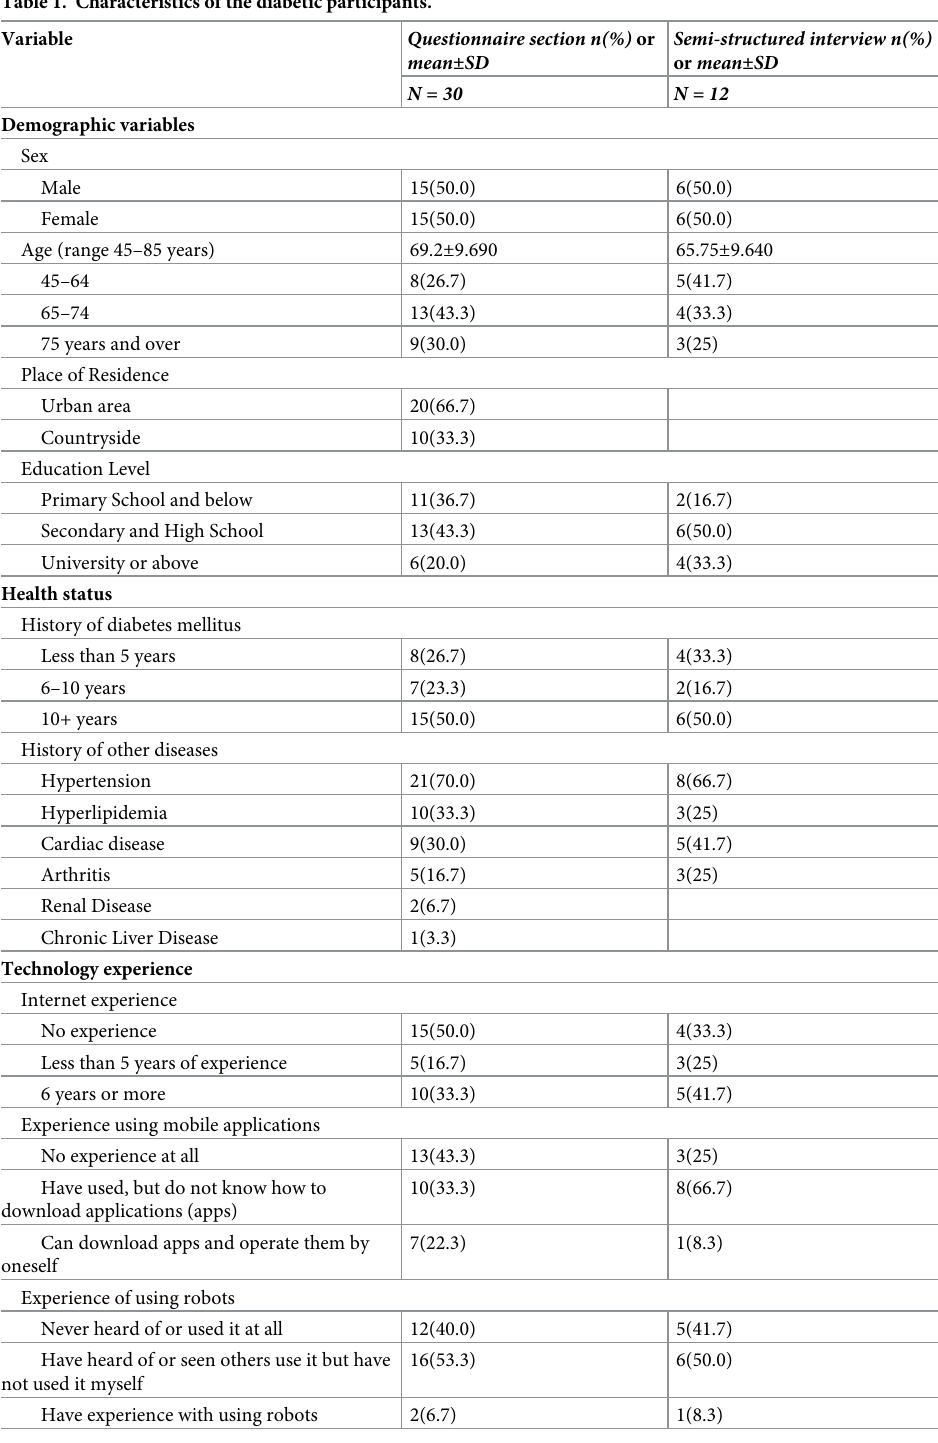
Table 1. Characteristics of the diabetic